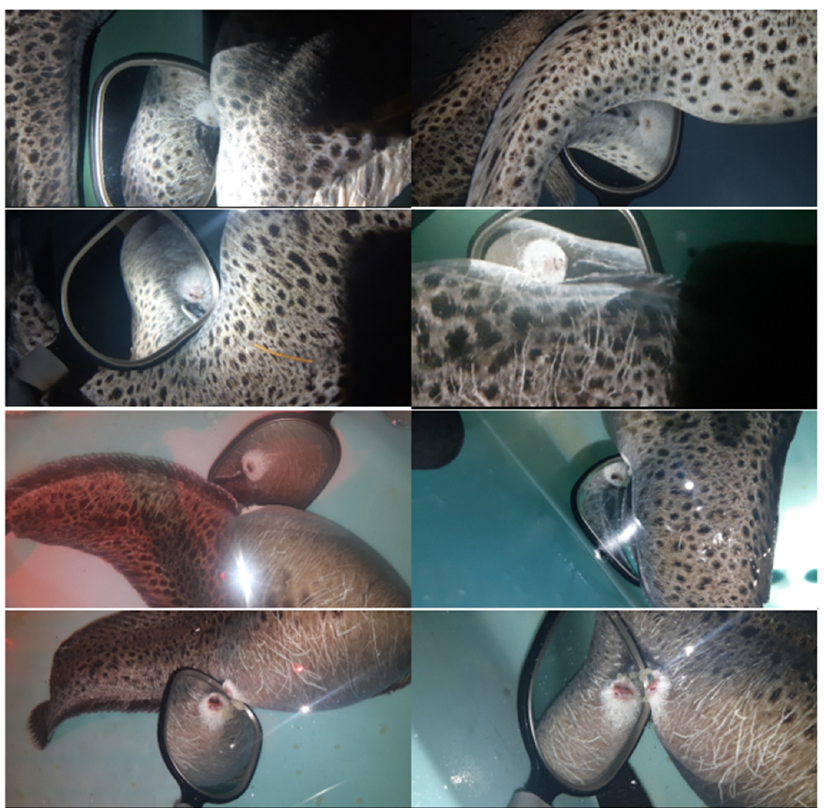
Figure 5. Use of a mirror to monitor genital pore opening of the females preparing to spawn. Source: MERINOV, Dupont-Cyr, B.-A.